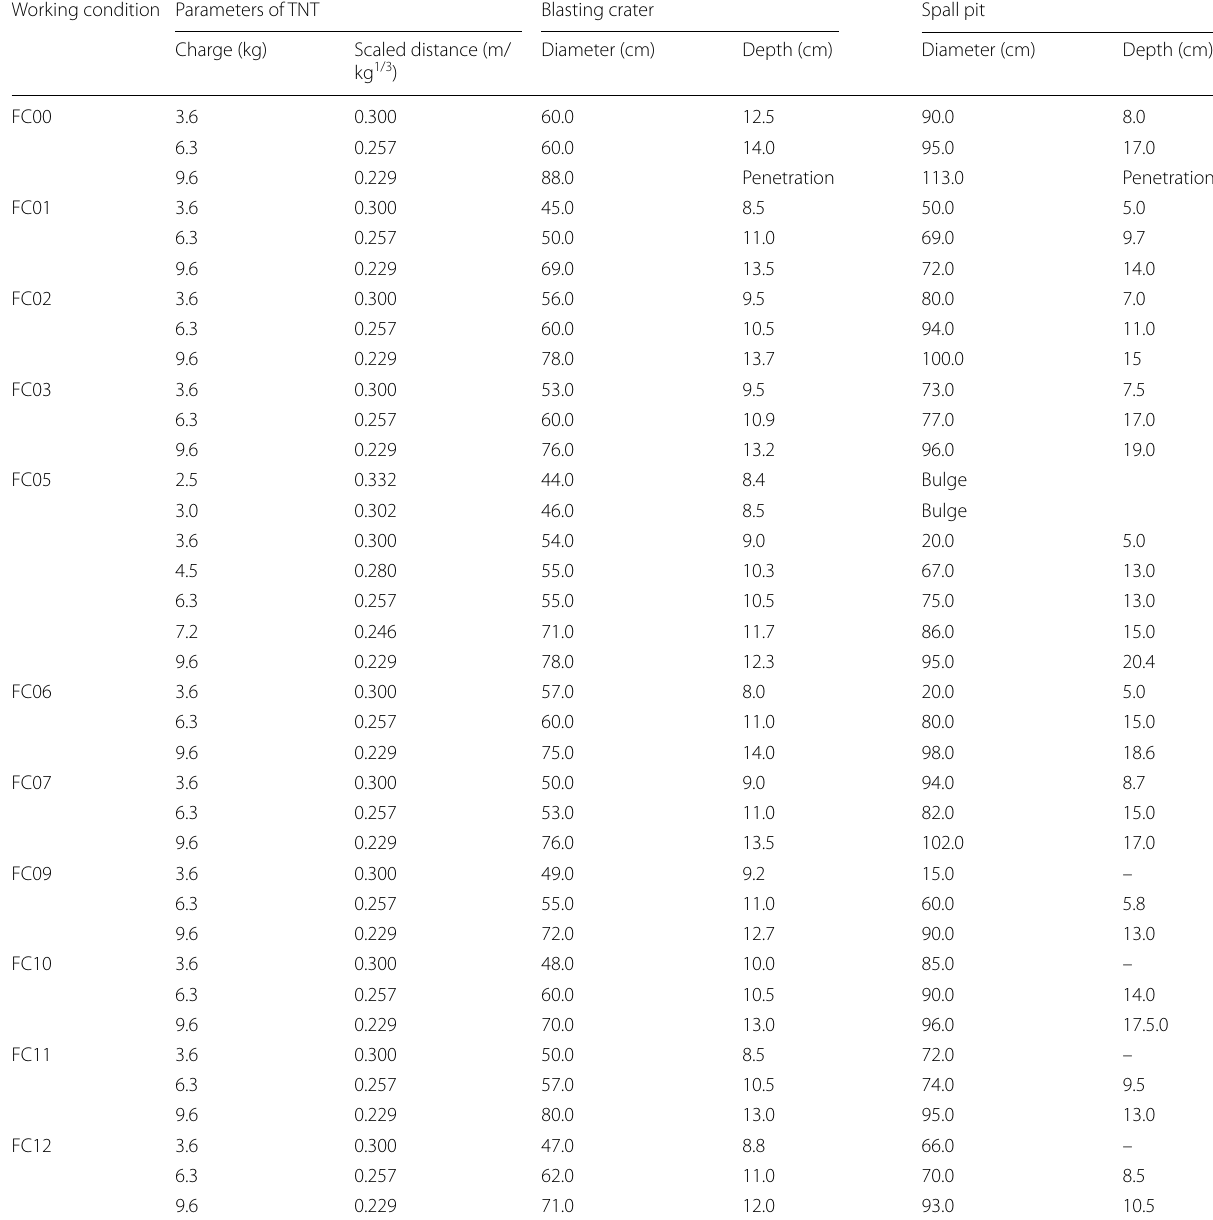
Table 5 The damage of slabs. Working condition Parameters of